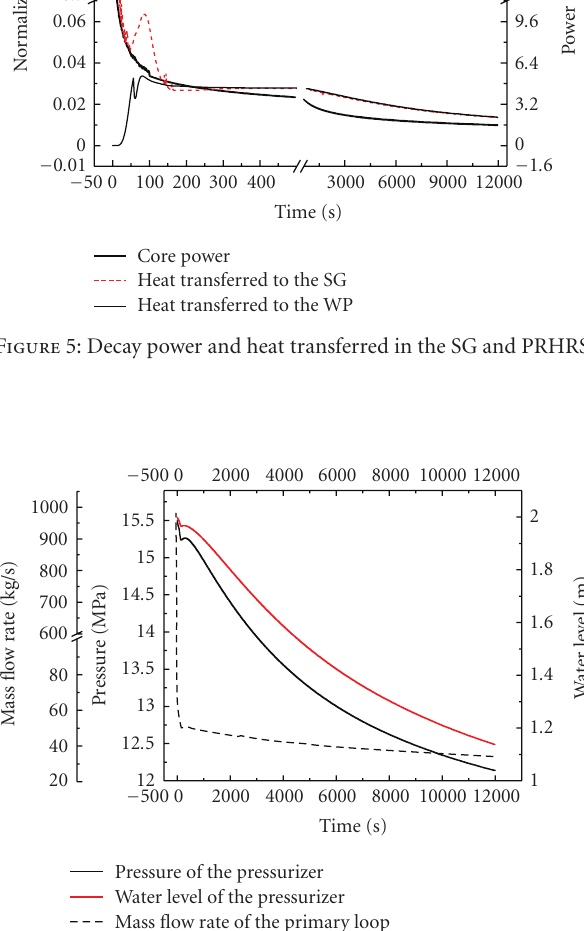
Figure 6: Mass flow rate of the primary loop, pressure, and water level of the pressurizer.